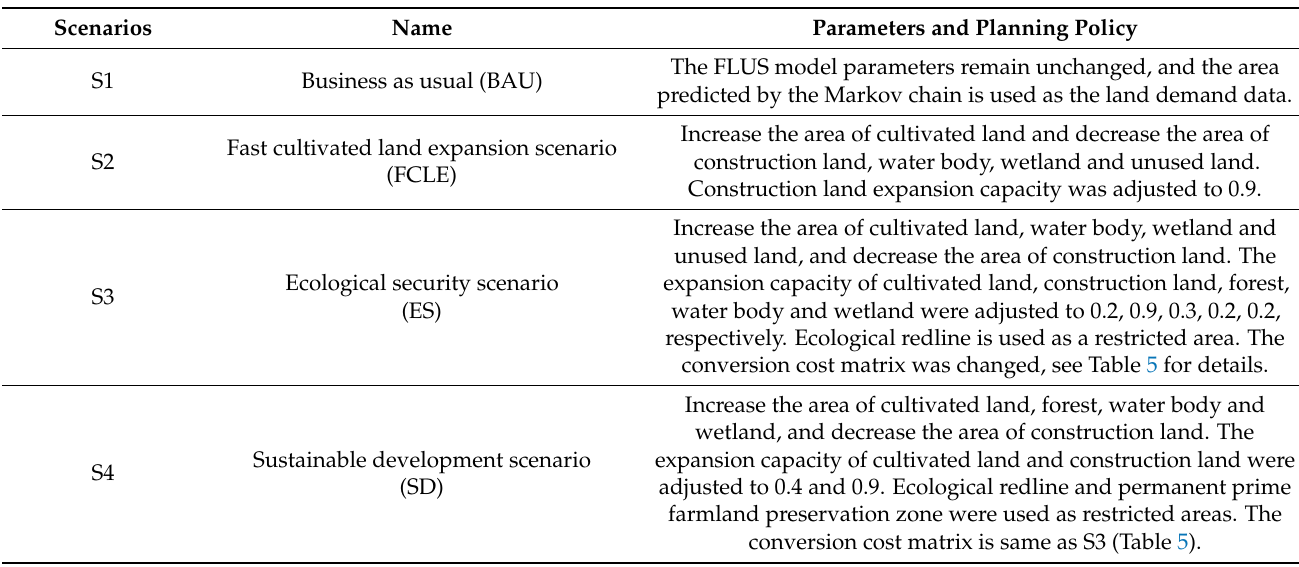
Table 2. Parameters and planning policy under four different scenarios.